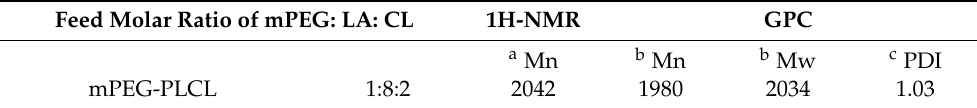
Table 1. Physical parameters of mPEG-PLCL. Feed Molar Ratio of mPEG: LA: